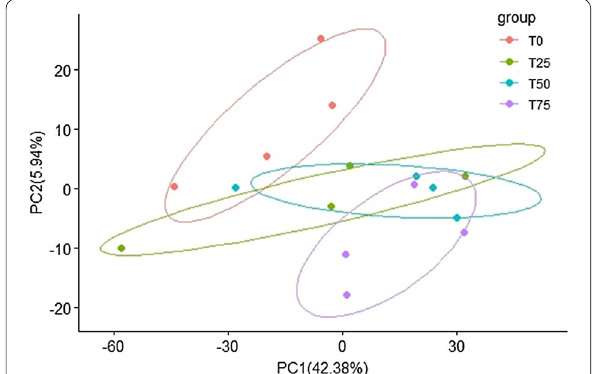
Fig. 5 Principal component analysis of the four treatment. T0: BPS replaces 0% of WCS; T25: BPS replaces 25% of WCS; T50: BPS